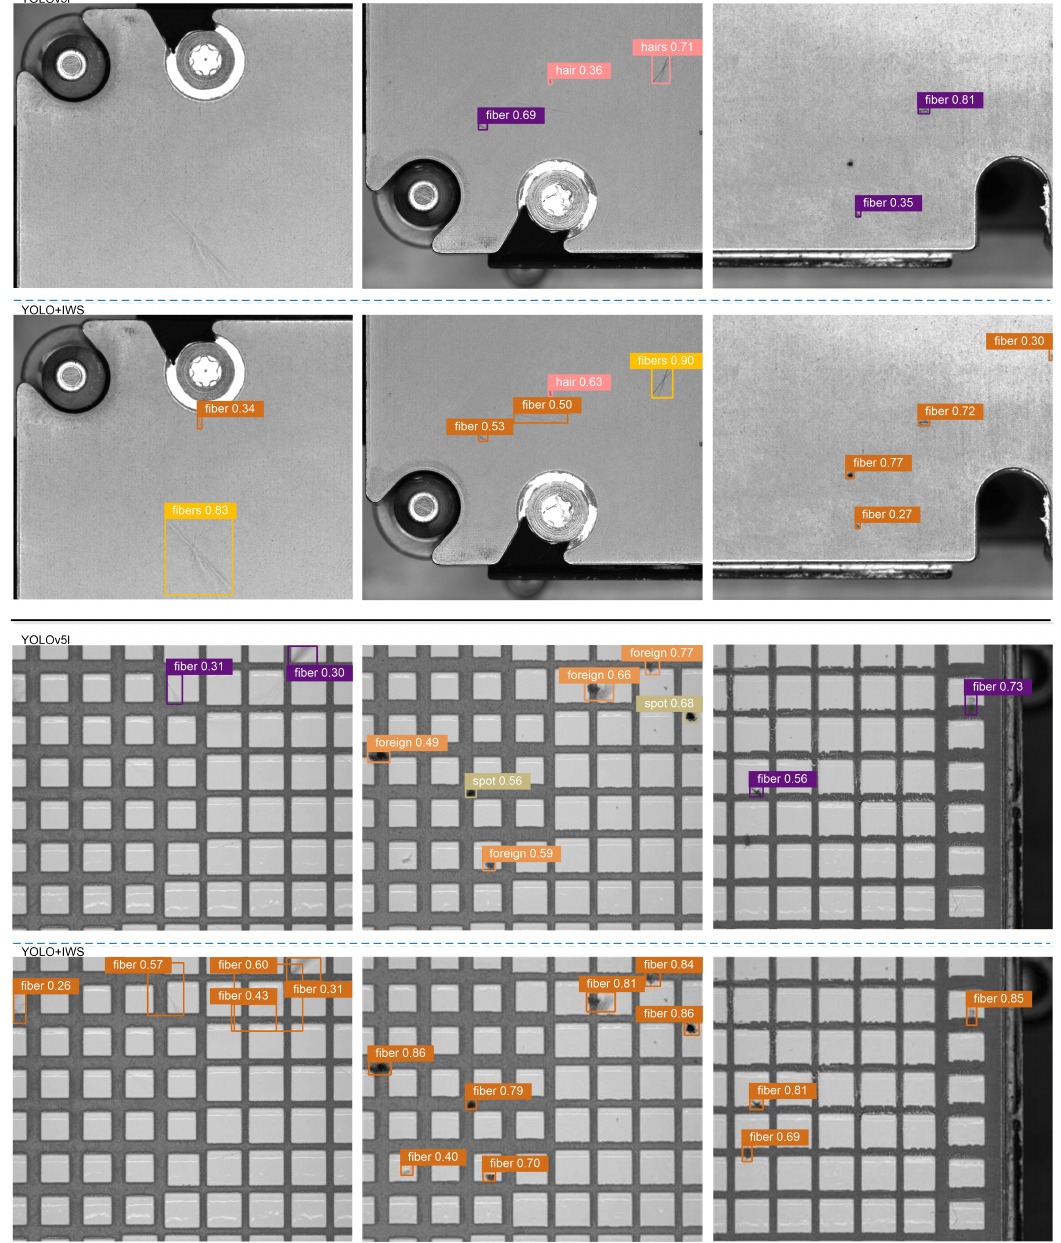
Figure A1. Visualization of detection results using YOLOv5l and YOLO+IWS in the